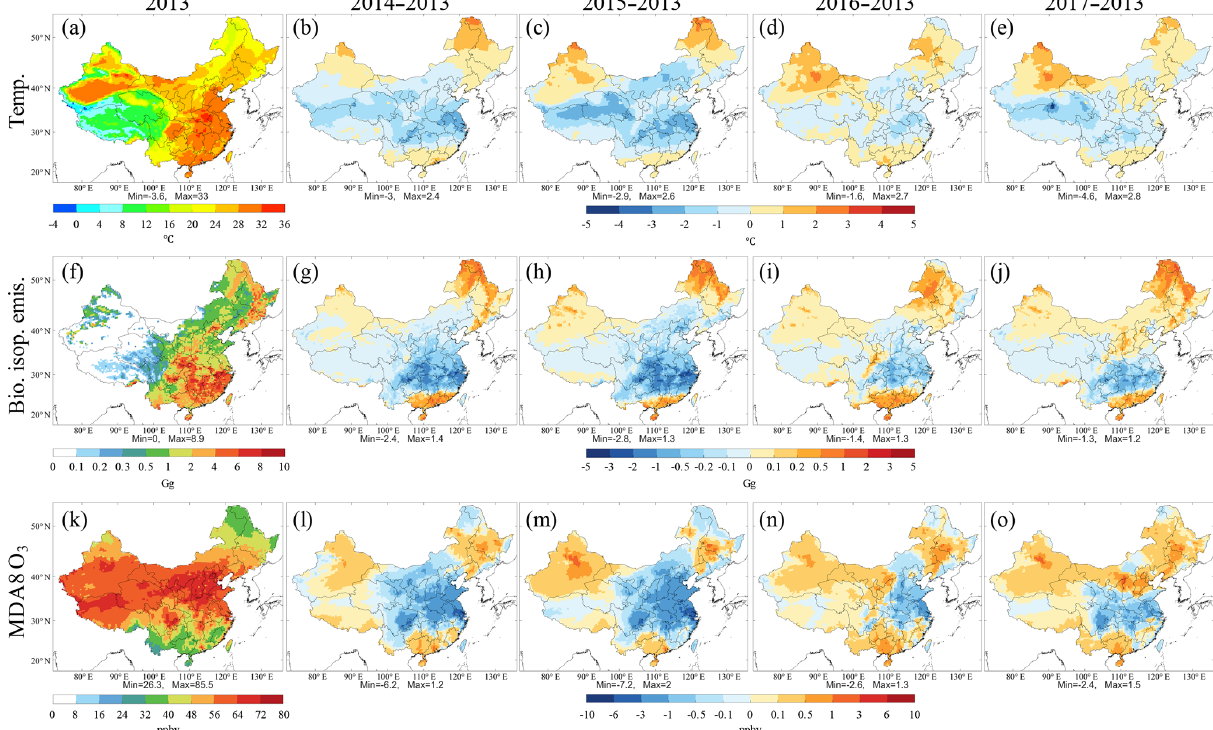
Figure 5. The simulated daytime averaged temperature at a height of 2m (Temp., a–e ) and total biogenic isoprene emissions (Bio. isop. emis., f–j ) in summer of 2013 from the base simulations and their changes in 2014, 2015, 2016, and 2017 relative to 2013. Panels (k) – (o) (MDA8 O 3 ) show the simulated summer surface MDA8 O 3 mixing ratios in 2013 from the base simulation and their changes due to variations in biogenic emissions in 2014, 2015, 2016, and 2017 relative to